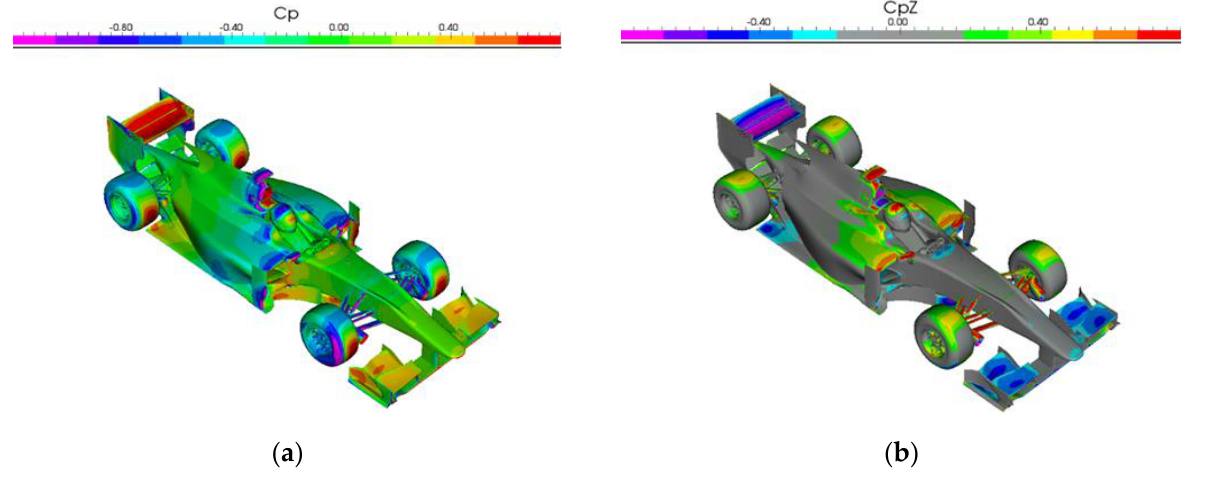
Figure 3. Plots of pressure coefficient Cp and vertical component alone CpZ: ( a ) pressure distribution over the entire car body; ( b ) downforce/lift contributions on upper surfaces.